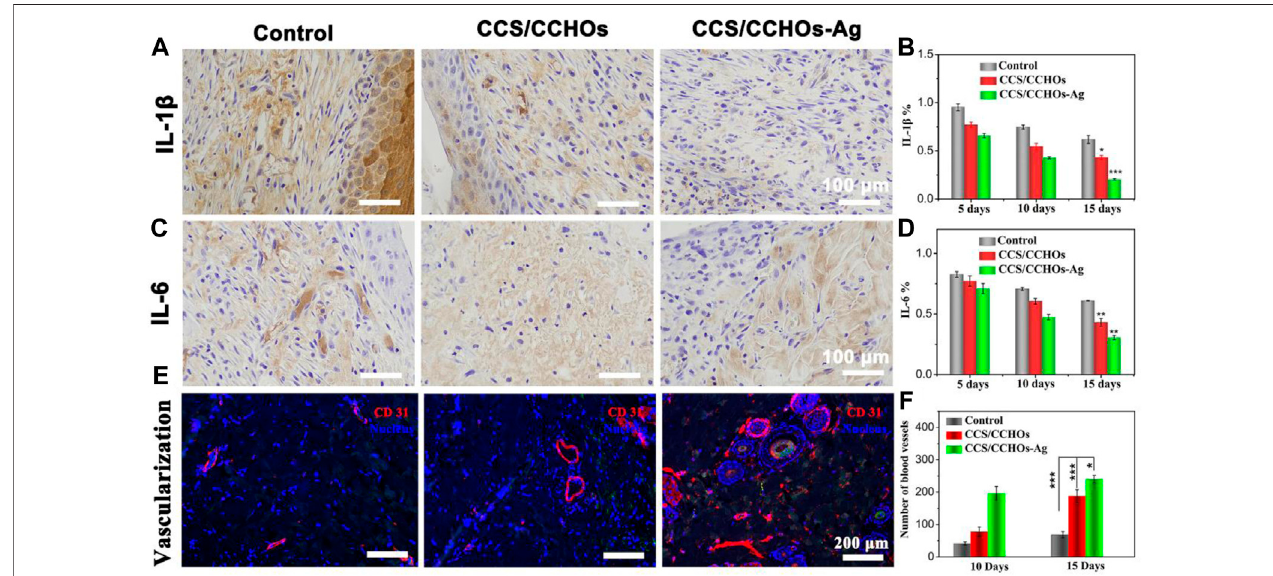
FIGURE 6 | Immunohistochemical staining of pro-in fl ammatory factors: (A) IL-1 β and (C) IL-6 after different treatments for 15 days, and (B,D) its corresponding results of semi-quantitative analysis of immunohistochemical staining. (E) Immuno fl uorescence staining of CD31 for blood vessel formation in vivo , and (C) quantitative counts of newly formed blood vessels per mm 2 at 15